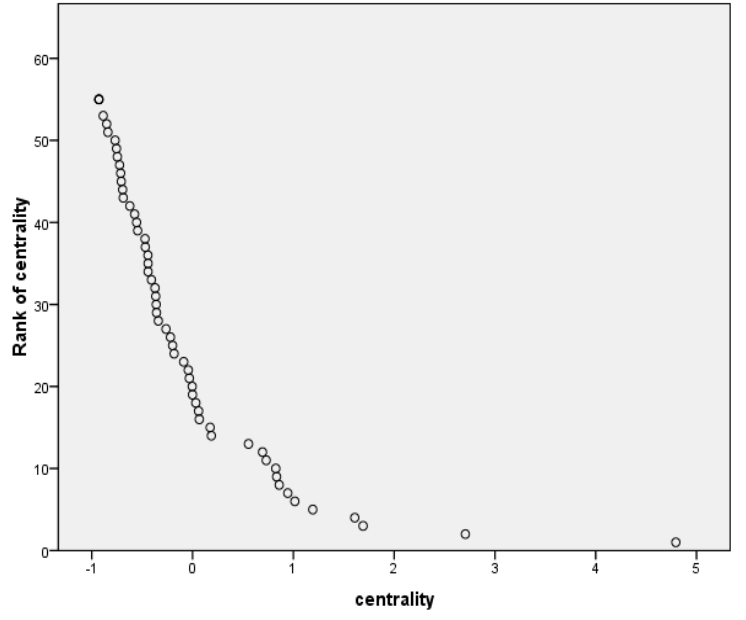
Figure 2. Scatterplot of PC “centrality” against its ranks.